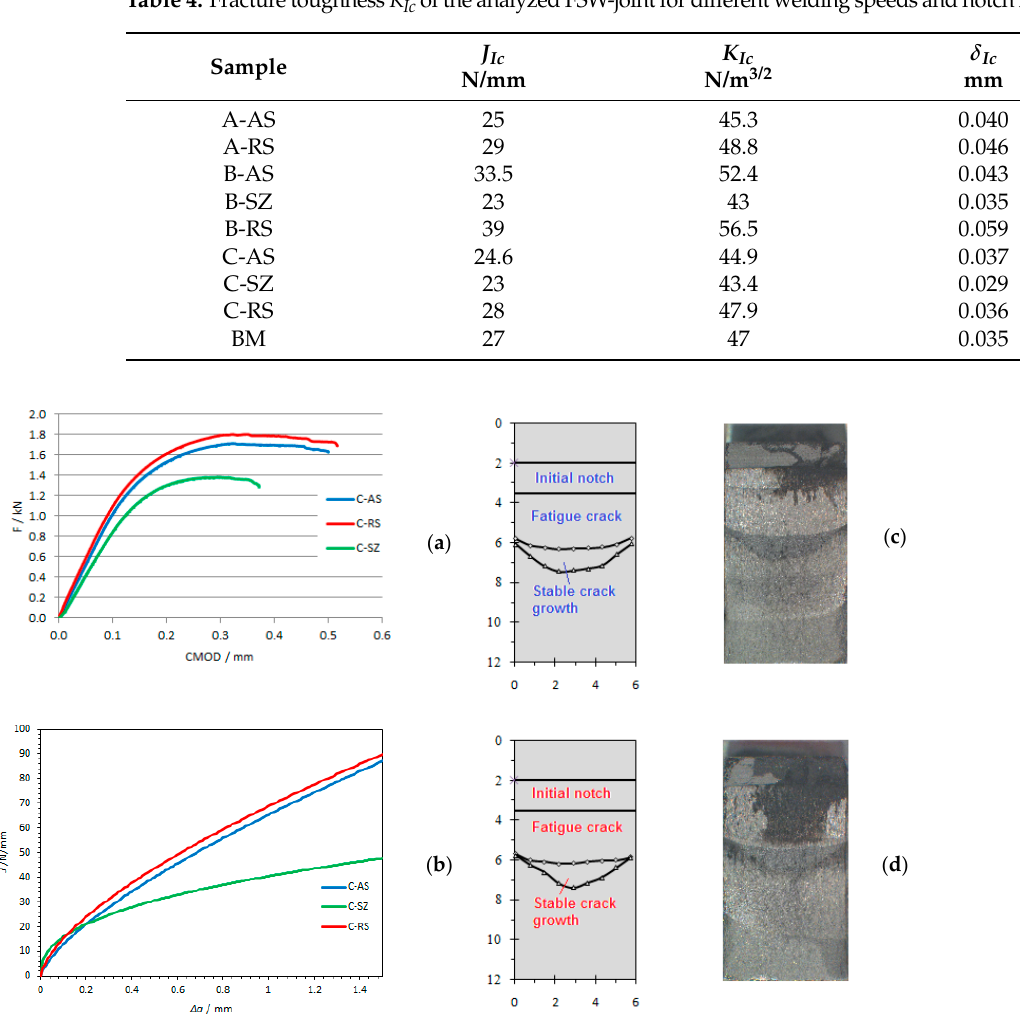
Figure 10. ( a ) Experimental data of load-displacement for specimens for welding speed v = 150 mm/min; ( b ) comparisons of J-R curves for specimen C-AS, C-RS and C-SZ; ( c ) crack surfaces on retreating side (RS) for specimen C-AS; ( d ) crack surfaces on retreating side (RS) for specimen C-RS. (C-AS—specimen for welding speed 150 mm/min (C)—notch position 4 mm from center of weld on advancing side (AS); C-RS—welding speed 150 mm/min (C)—notch position 4 mm from center of weld on retreating side (RS); C-SZ—welding speed 150 mm/min (C)—notch position in center of weld